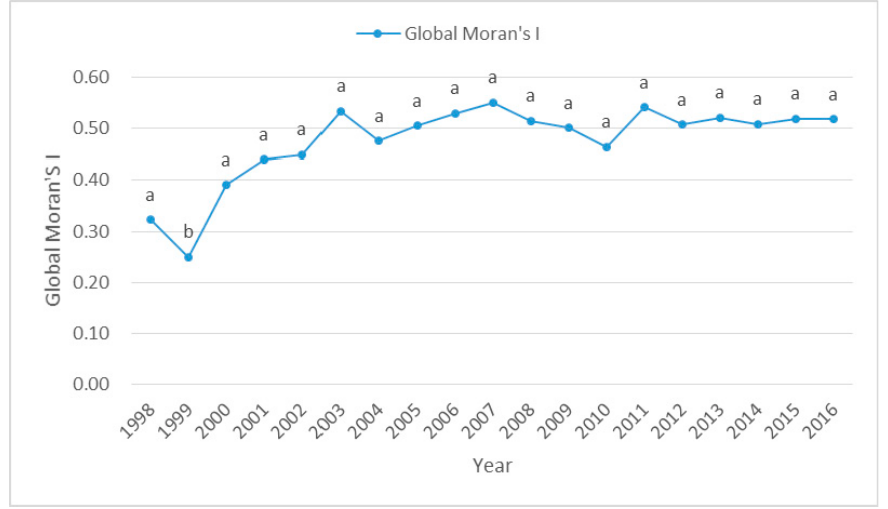
Figure 9. Global Moran’s I of PM 2.5 concentration for 31 provinces, 1998–2016. Notes: a, b represent coefficients significant at the 1%, 5% levels,